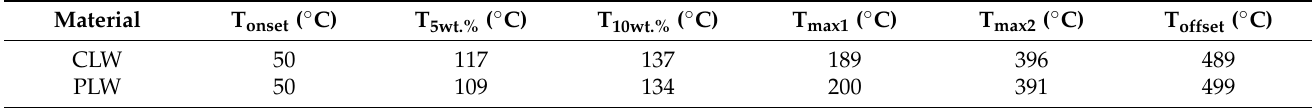
Table 4. Thermal degradation properties of bio − polyols.